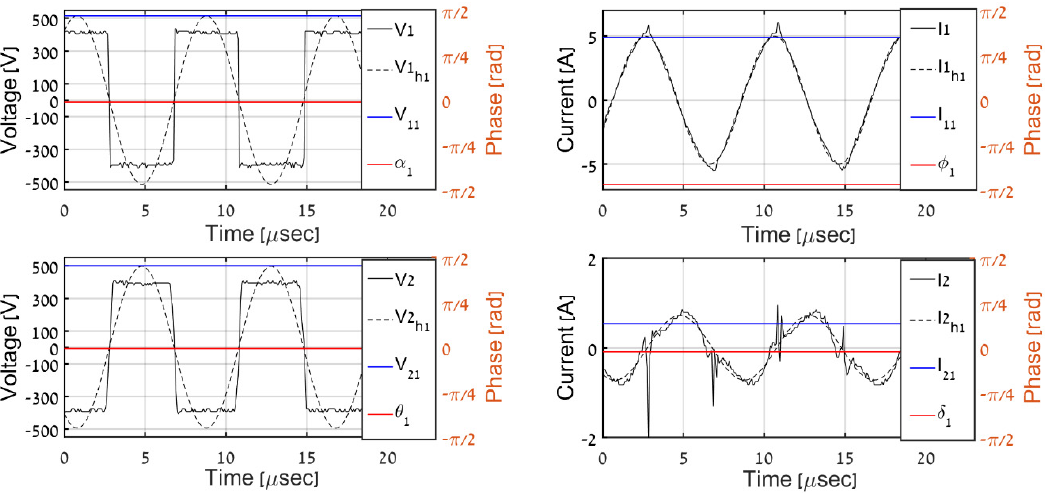
Figure 15. Experimental results, P O = 200 W.